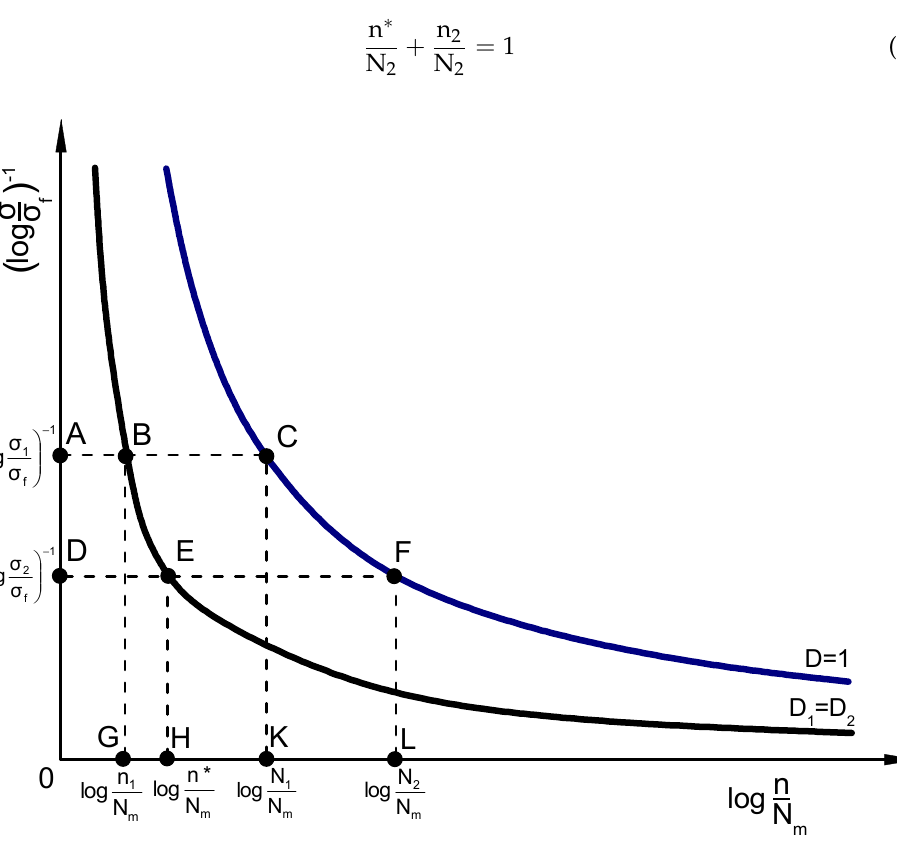
Figure 3. Schematic representation of fatigue damage accumulation regarding a two-stage loading.